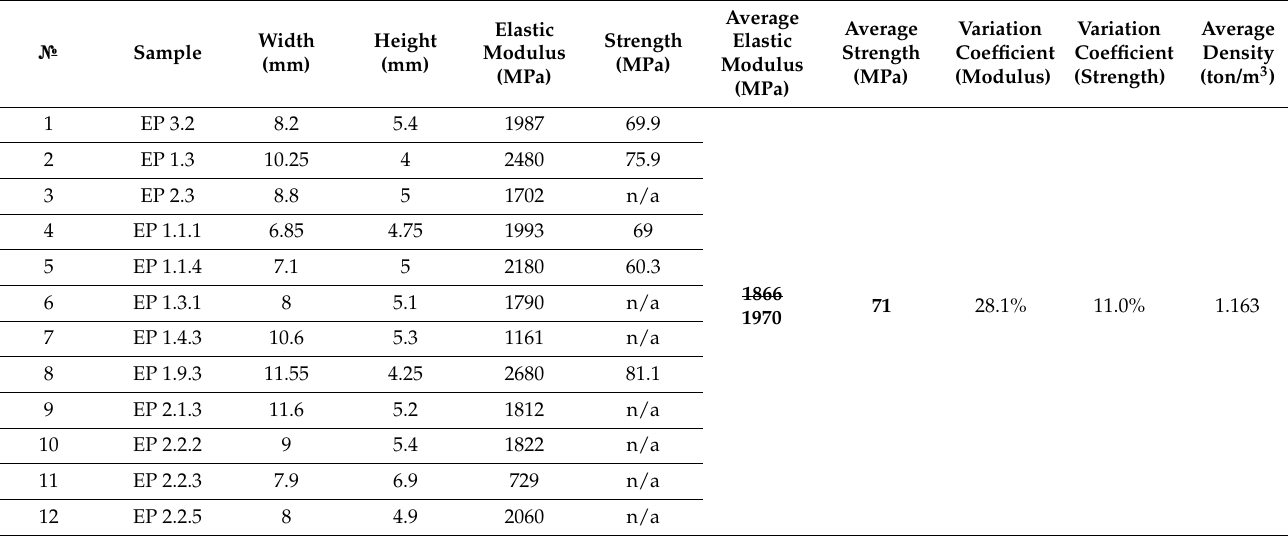
Table A26. Results of three-point bending tests at 100 ◦ C with unfilled binder (EP1,